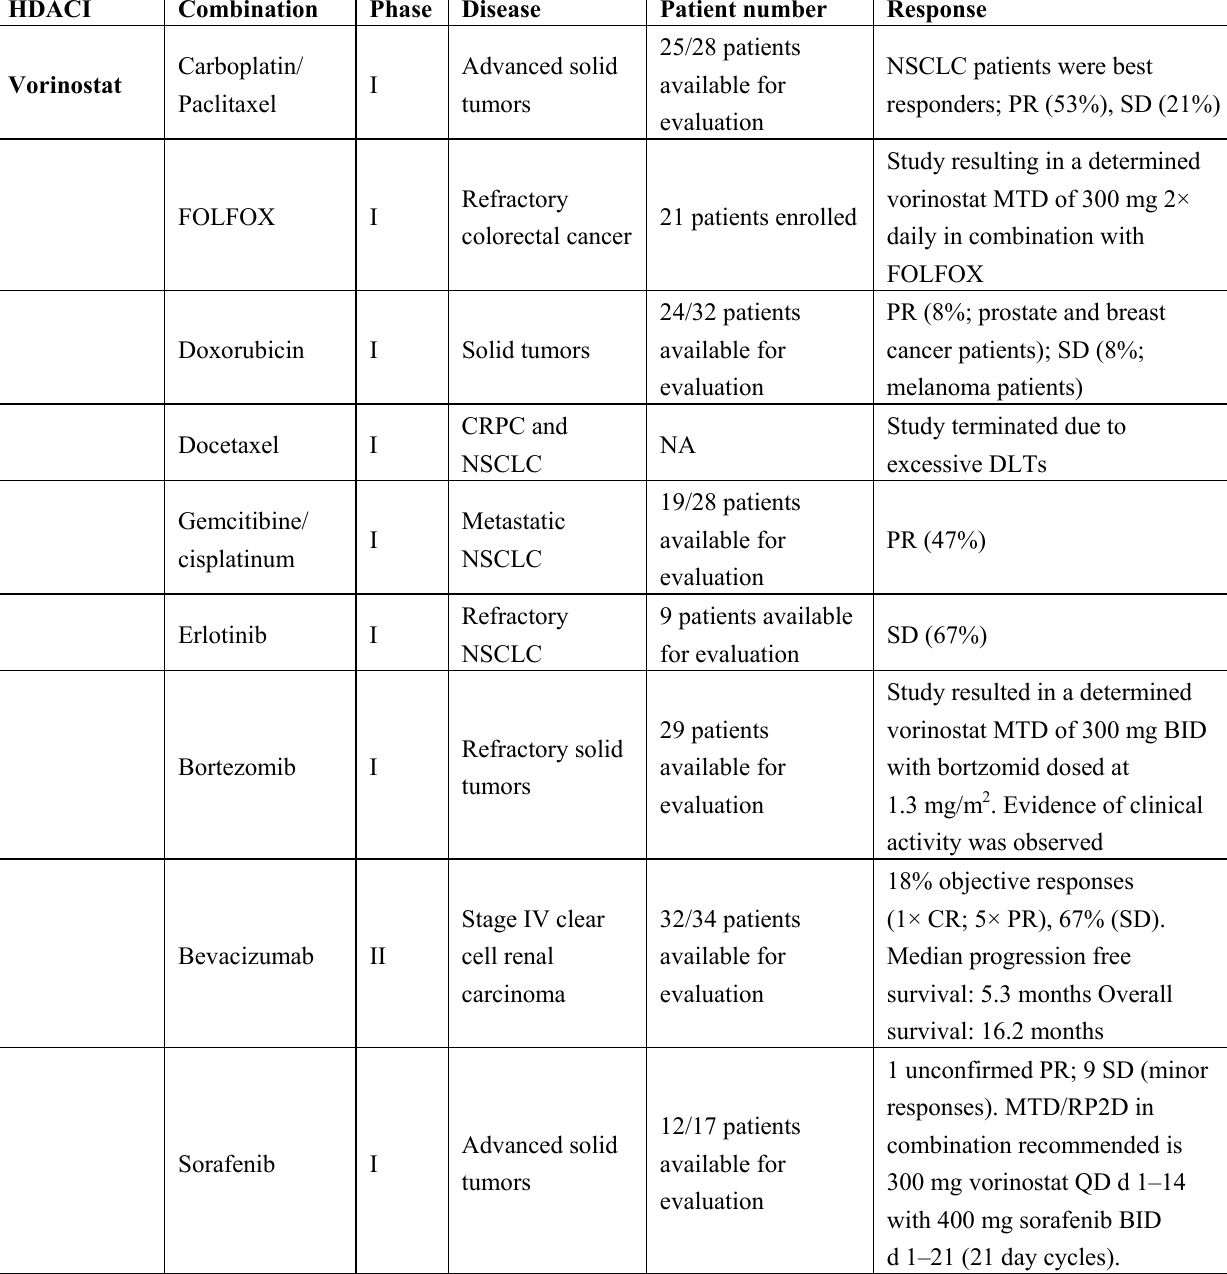
Table 4. Summary of current clinical trails involving combination strategies with